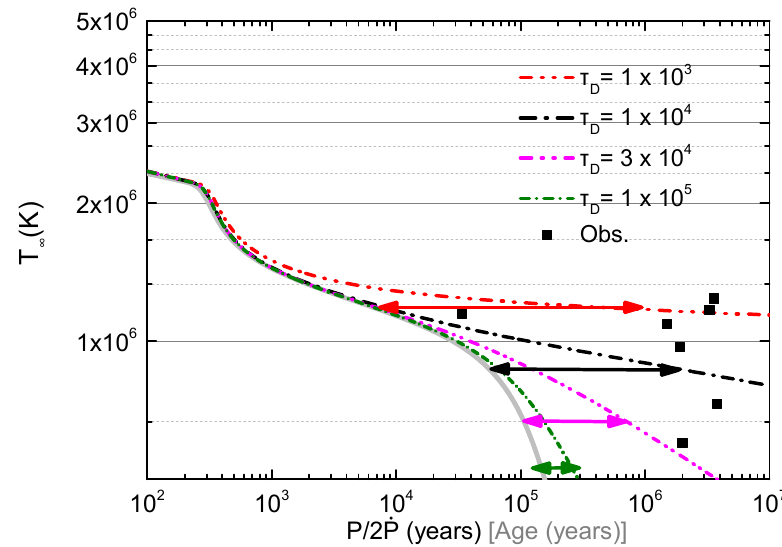
Figure 6. Thermal evolution of a 1.55 M (cid:12) neutron star undergoing magnetic field decay. The solid washed gray line represents the temperature as a function of the real age of the object. For the other curves the x -axis represent the spin-down age observed. We also plot a few arrows depicting the discrepancy between the true and spin-down